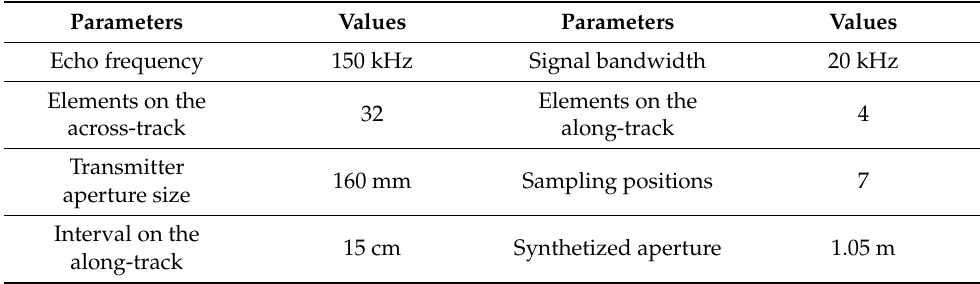
Table 3. Tank experiment